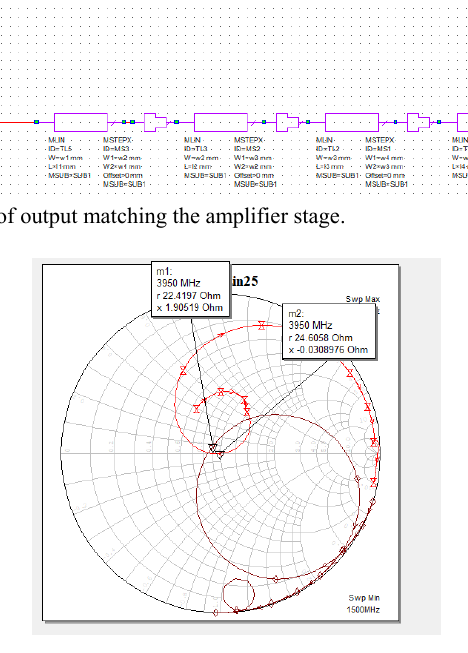
Fig. 6. Impedance of the designed input and output matching circuits after adjustment according to the results of electromagnetic simulation.